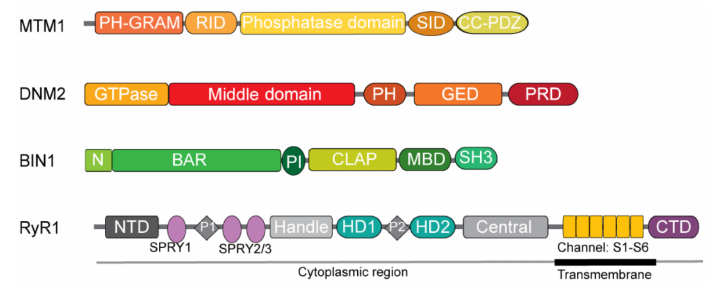
Figure 2. Scheme of MTM1, DNM2, BIN1, and RyR1 protein domains. MTM1: PH-GRAM (Pleckstrin homology-glucosyltransferase; Rab-like GTPase activator and myotubularin), RID (Rac1-induced recruitment domain), SID (SET interacting domain), CC-PDZ (coiled coil; PSD95, disc large, ZO-1). DNM2: PH (Pleckstrin-homology), GED (GTPase effector domain), PRD (proline-rich domain). BIN1: N (N-terminal amphipathic helix α ), BAR (Bin-amphiphysin-Rvs), PI (phosphoinositides), CLAP (clathrin and AP2 binding), MBD (Myc binding domain), SH3 (SRC homology 3). RyR1: NTD (N-terminal domain), SPRY (SPla and the RYanodine receptor), HD (helical domain), CTD (C-terminal